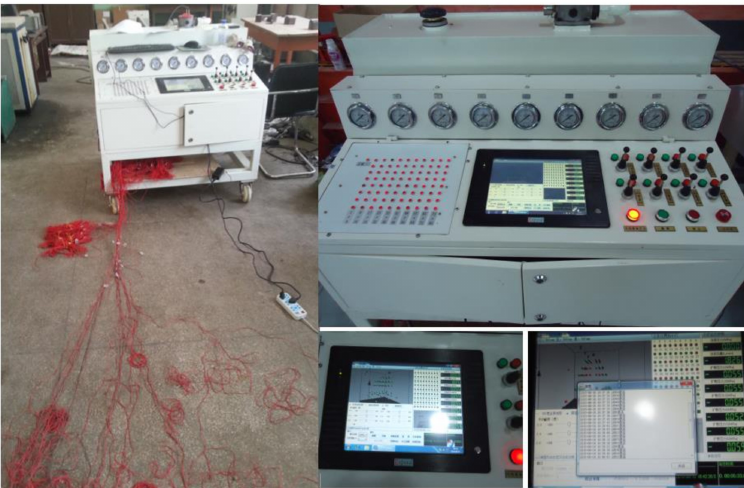
Figure 3. The visualization platform of the grouting